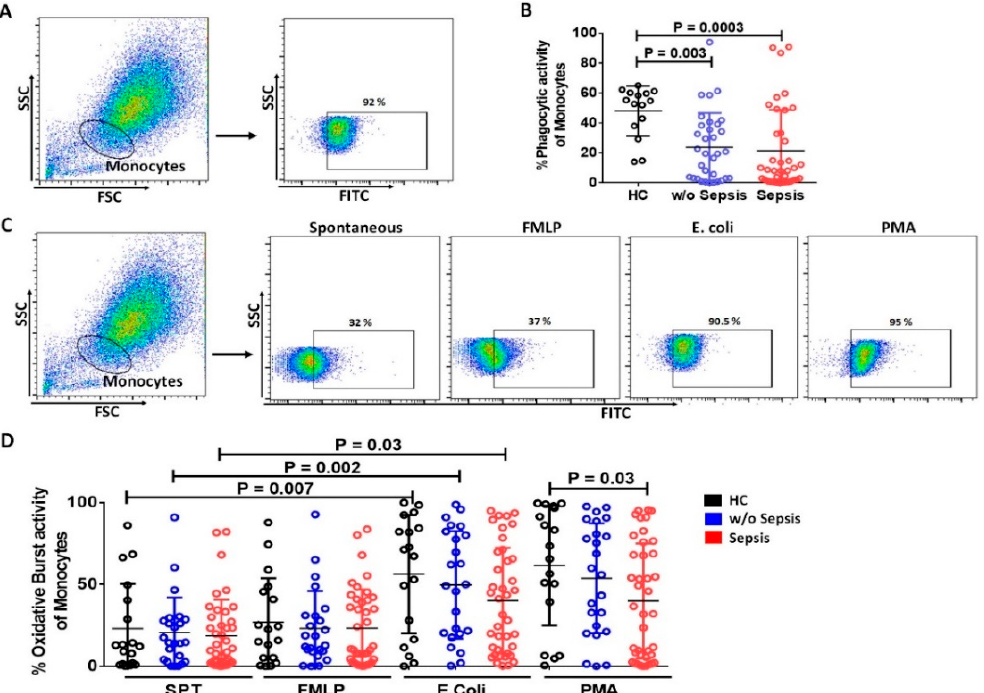
Figure 4. Functionality of monocytes. ( A ) Gating strategy for phagocytic activity of Monocytes. ( B )